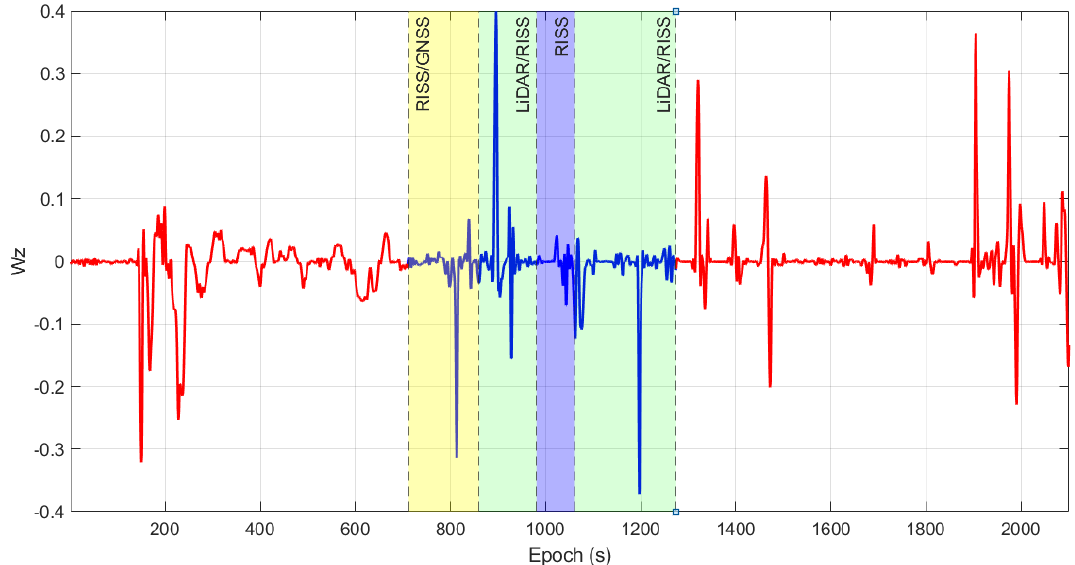
Figure 25. The ( w ) measured by the IMU in the Selected Scenario.